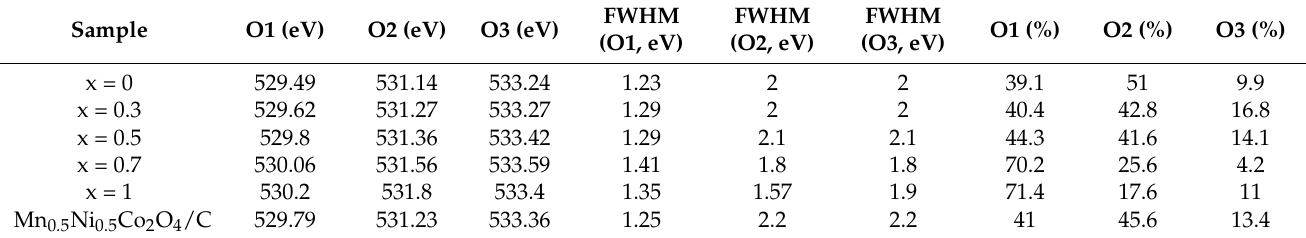
Table 2. BEs (in eV), FWHM (in eV), and relative percentage areas (in %) of the three components of the O 1s core level for the MnNiCoO series and Mn 0.5 Ni 0.5 Co 2 O 4